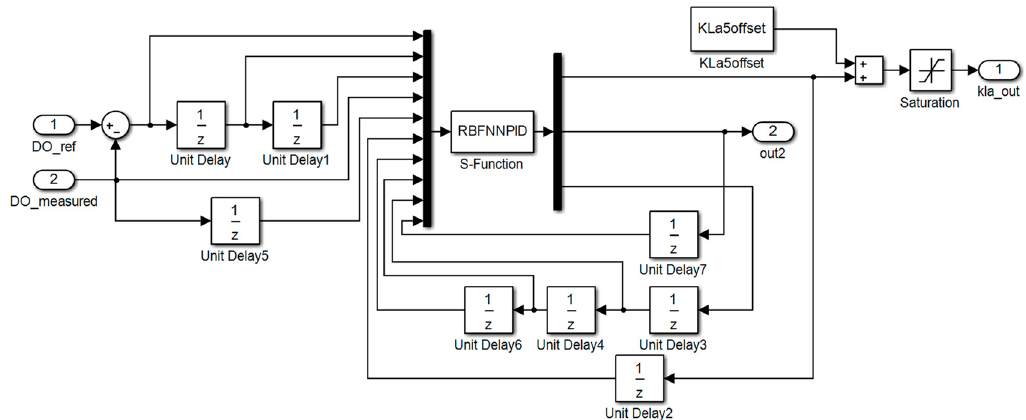
Figure A2. Detailed structure of the RBFNNPID controller.